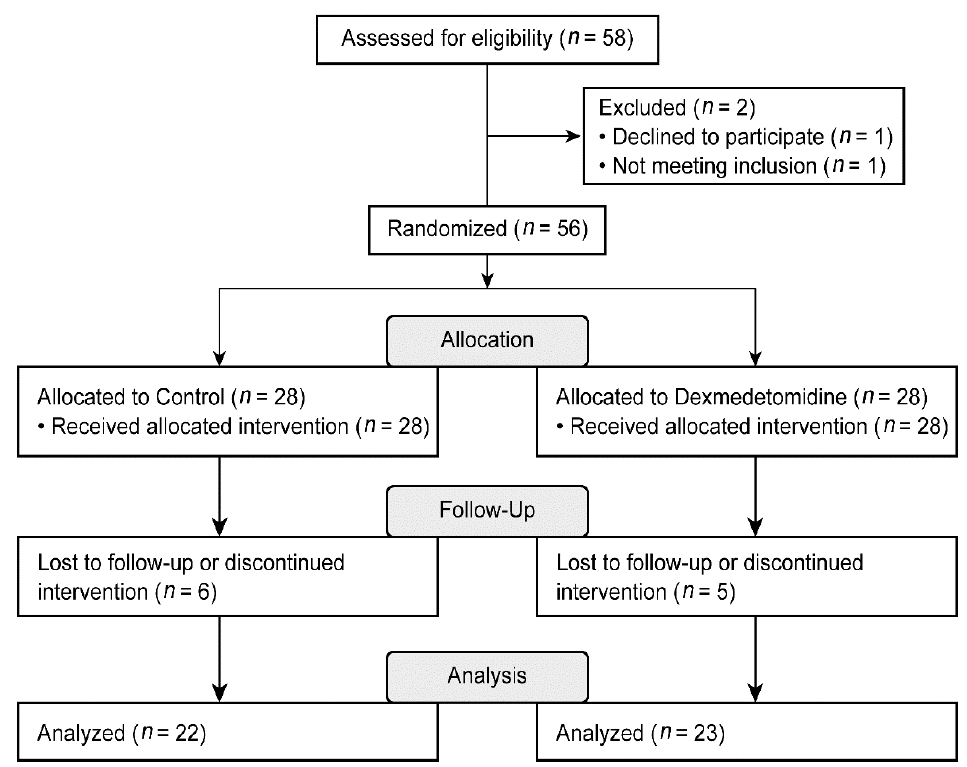
Figure 1. Consolidated Standards of Reporting Trials (CONSORT) flow diagram.